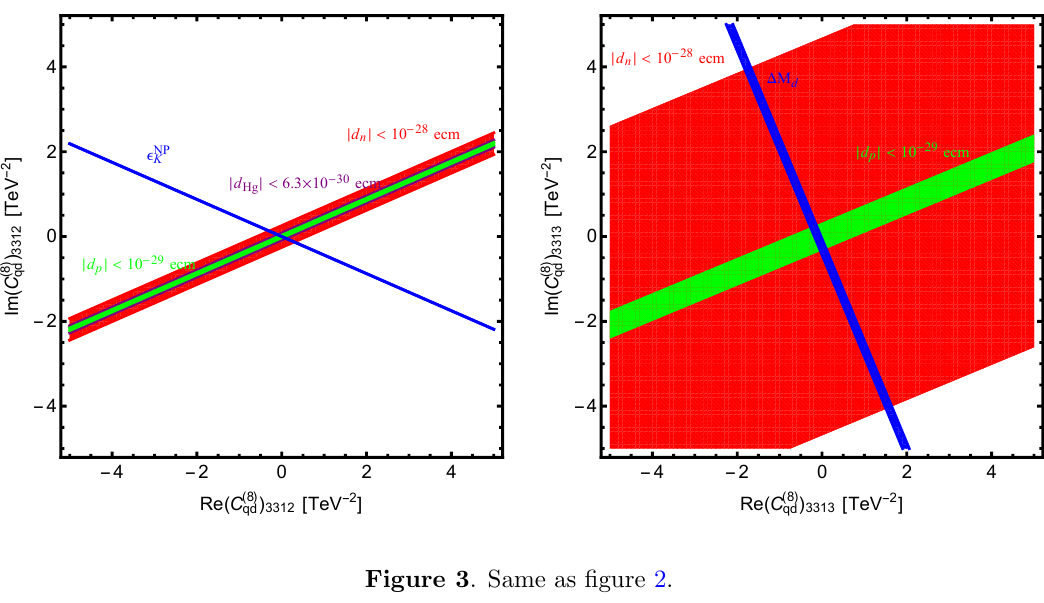
Figure 3 . Same as (cid:12)gure